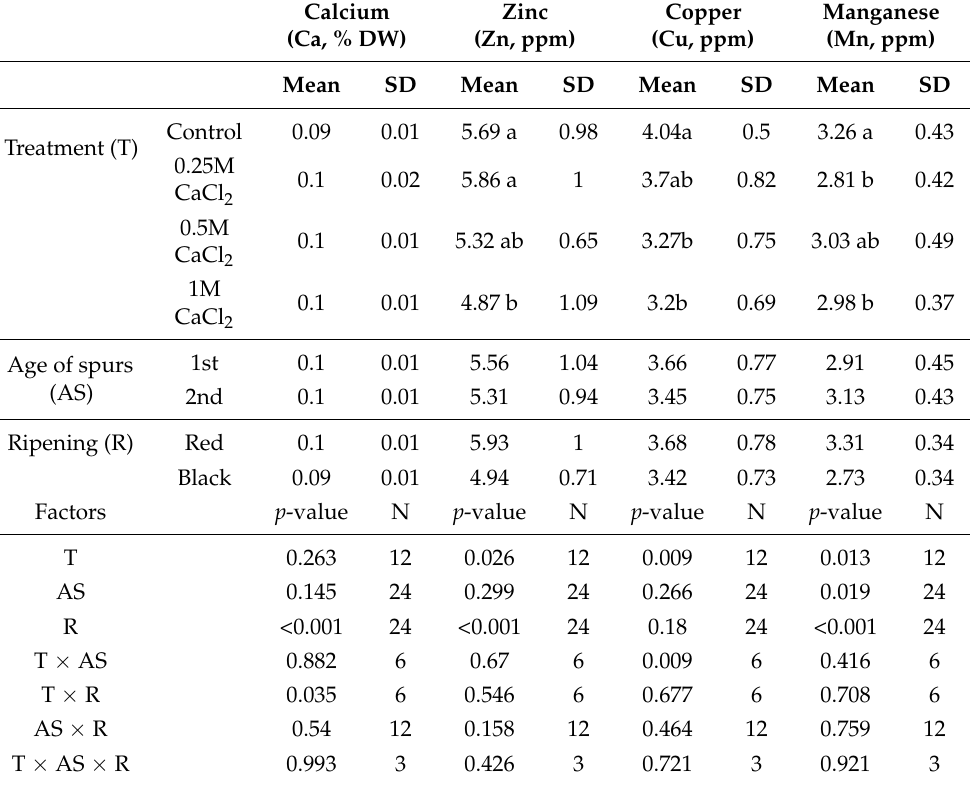
Table 2. The effect of calcium treatments (0, 0.25, 0.5, and 1M CaCl 2 *2H 2 O), ages of short spurs (1- and 2-year-old spurs), and the ripening stage (red and black colour fruits) in the Ca, Zn, Cu, and Mn content of